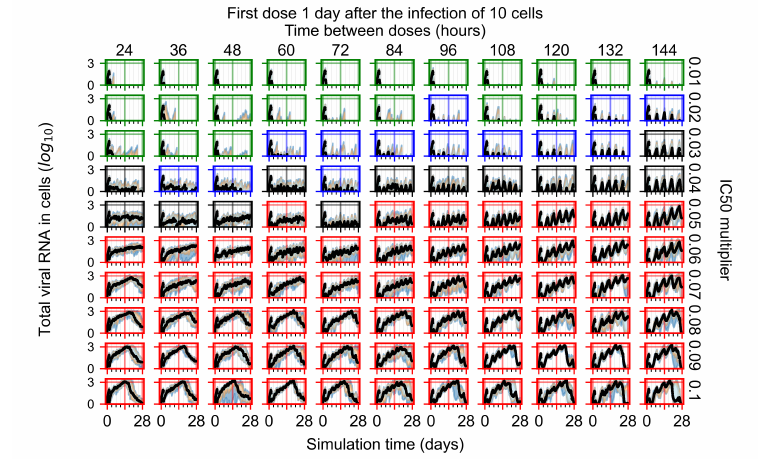
Figure A98. Amount of viral RNA in infected cells (arbitrary units), Y axis in log scale, and exponent values as tick marks.